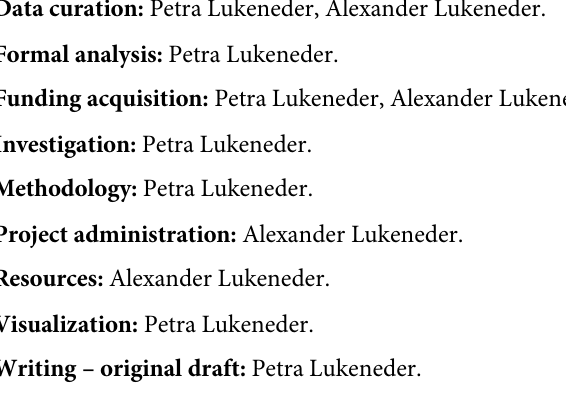
S3 Table. Micro-CT Scan parameters for fossil specimens. S4 Table. Measurements conducted on fossil specimens. Each specimen of each sample is listed here measured separately; h height of C structure; l length of processus; l length of c p w wing; w base-length of wing element; ac height of arm cartilage; ac base-length of arm carti- b h b lage; all measurements in mm. Elements could not be measured in GBA specimens and are therefore not listed. Only specimens listed, where measurements were possible. S5 Table. Volumes of fossil specimens, obtained from Micro-CT data.